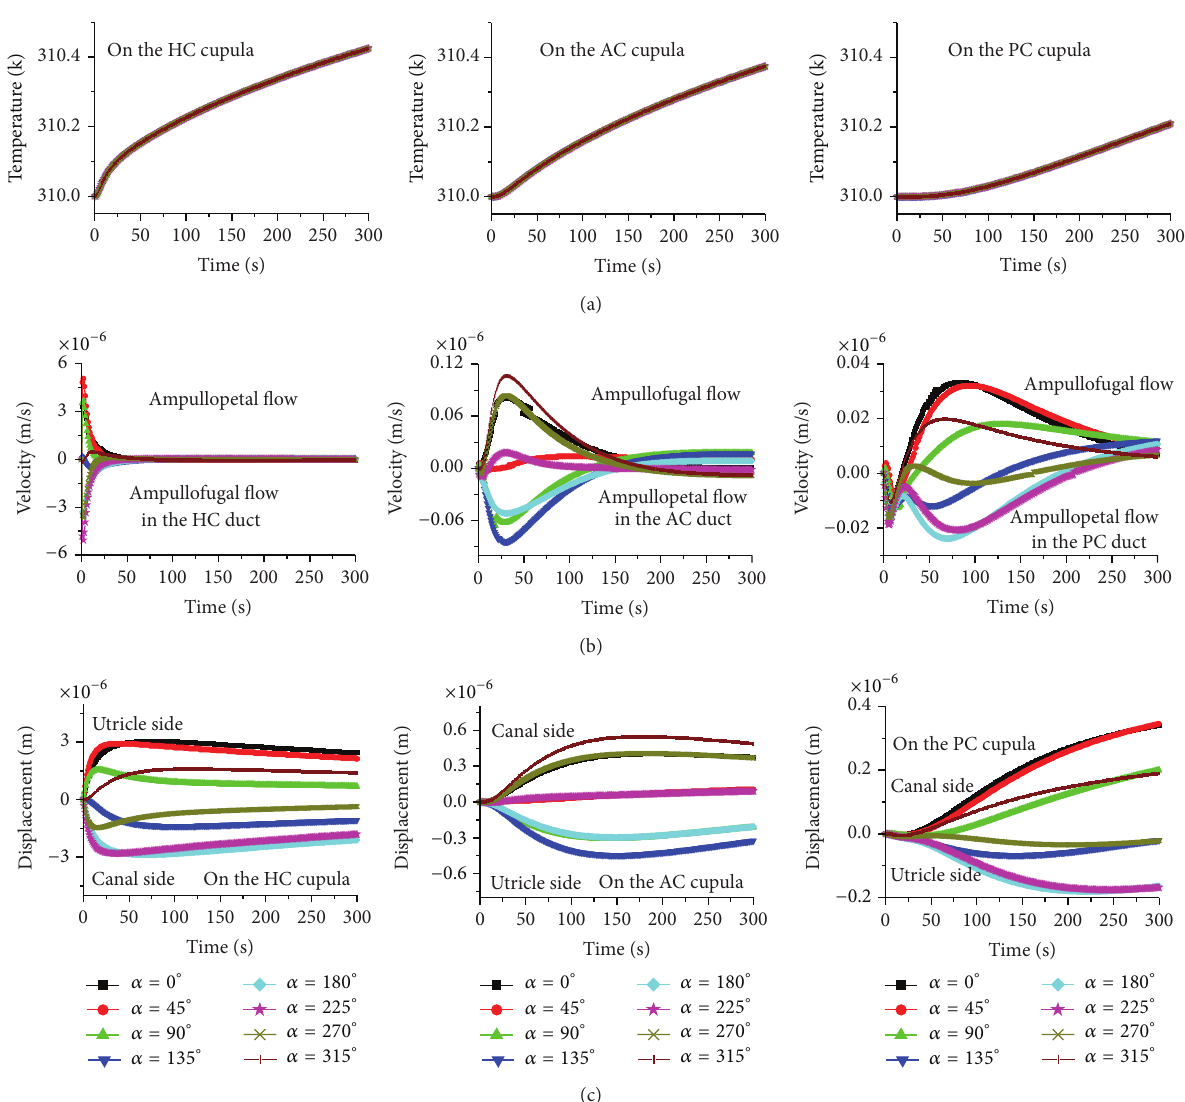
Figure 4: The effects of head position on the caloric responses when the gravity is parallel to the plane 𝛼 . (a) Temperature, (b) endolymph velocity, and (c) cupula